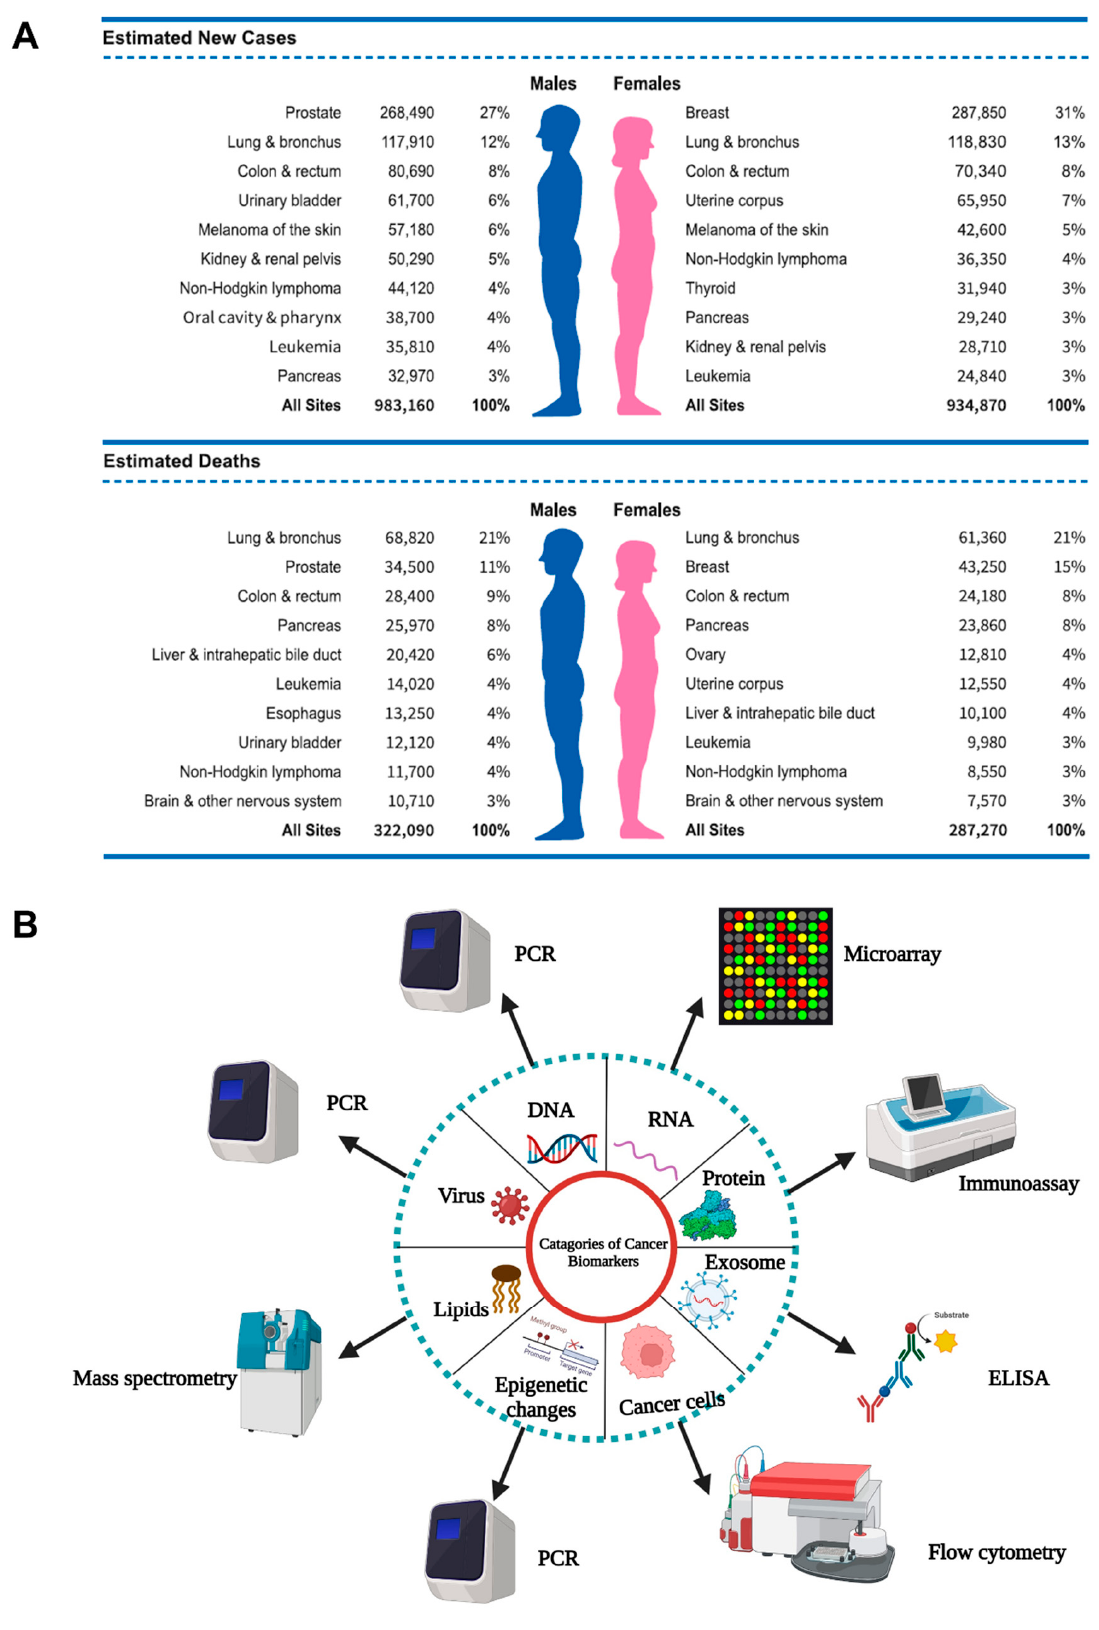
Figure 1. ( A ) Top ten major cancers and mortalities by sex in 2022 (USA) [25]. ( B ) Schematic representation of cancer biomarkers and their detection approaches (Created with Biorender.com (accessed on 13 February 2023)).